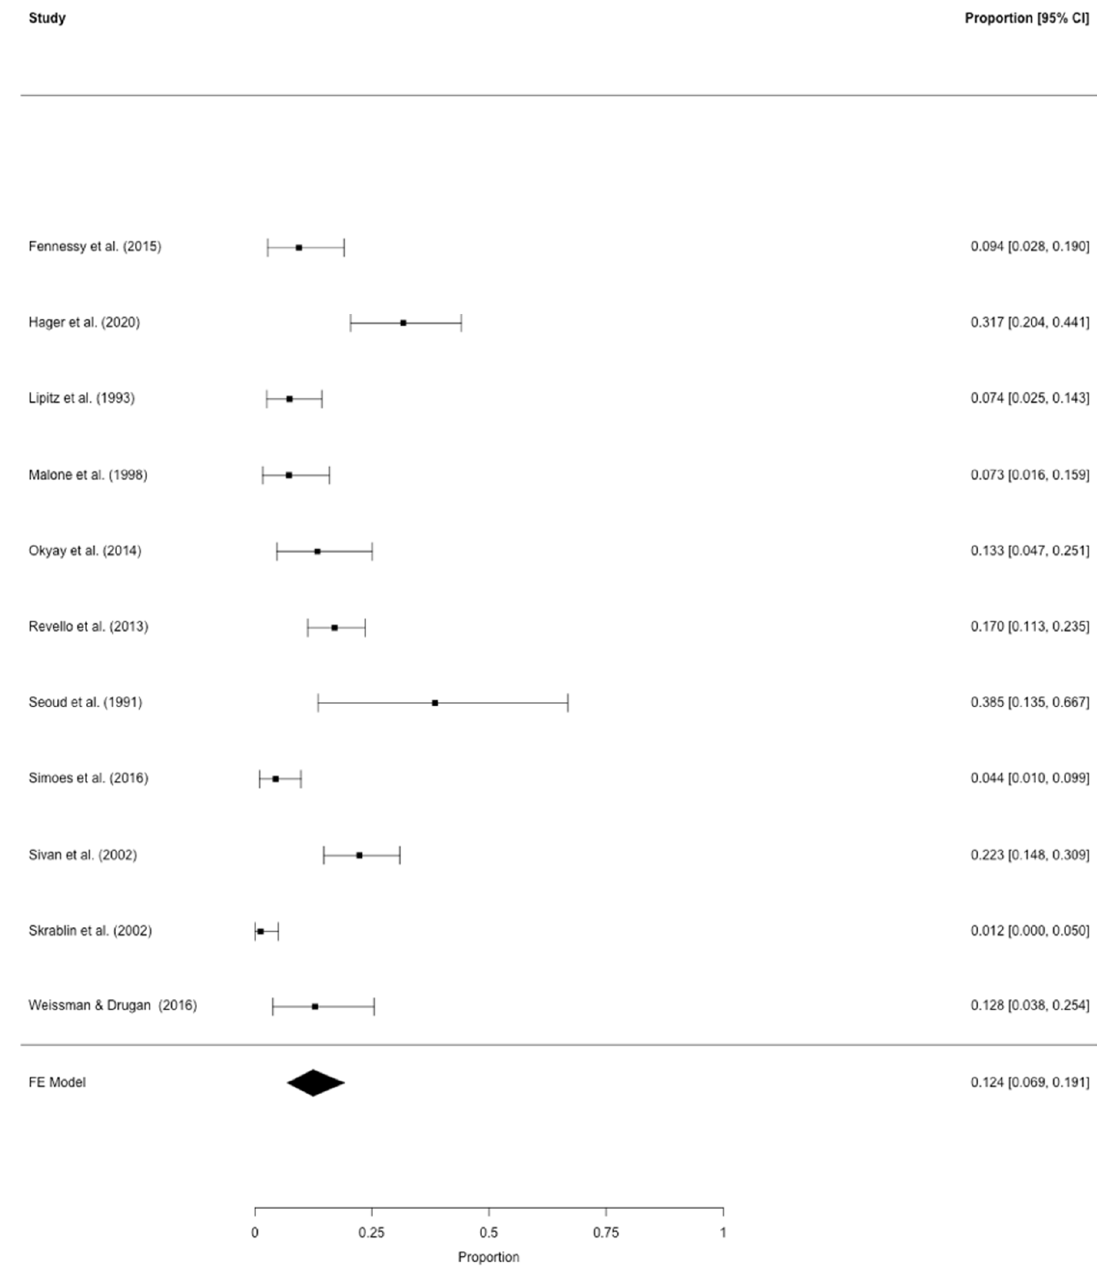
Figure 3. Meta-analysis of all 11 studies on GDM prevalence in triplets that used a sound GDM definition [9,33,37,41,43,48,52,53,55,59].